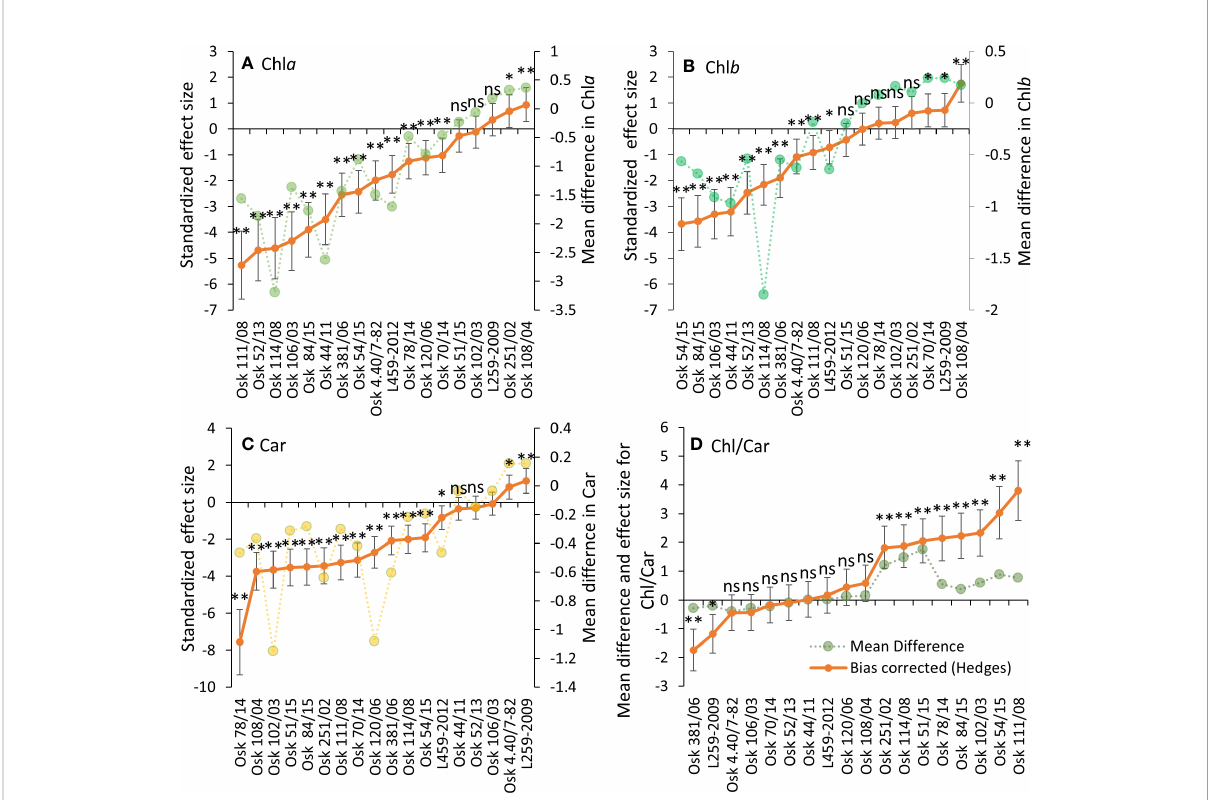
FIGURE 3 Hedges bias-corrected effect size (with con fi dence interval) and the mean difference between PEG-induced drought and control treatments for pigment content: Chl a (A) , Chl b (B) , Car (C) , and their ratio (D) in 18 genotypes of wheat seedlings. Signi fi cant effects of PEG induced drought are marked with asterisks (* p< 0.01, ** p< 0.001), and ns stands for non-signi fi cant (p >